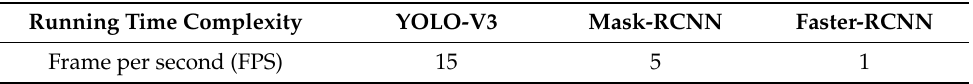
Table 2. Running time complexity comparison with state-of-the-art